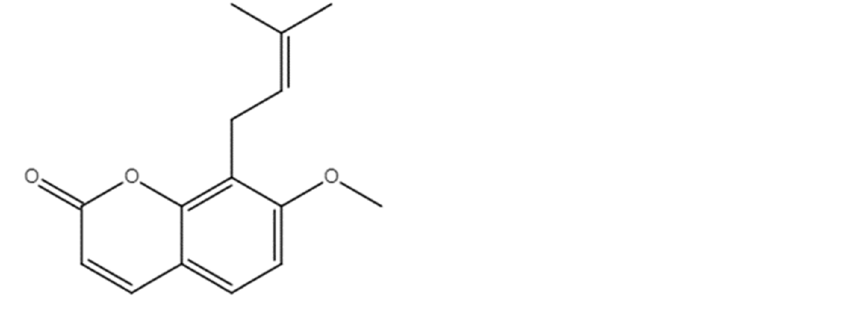
Figure 1. Chemical structure of Osthole [7 ‐ Methoxy ‐ 8 ‐ (3 ‐ methyl ‐ 2 ‐ butenyl)